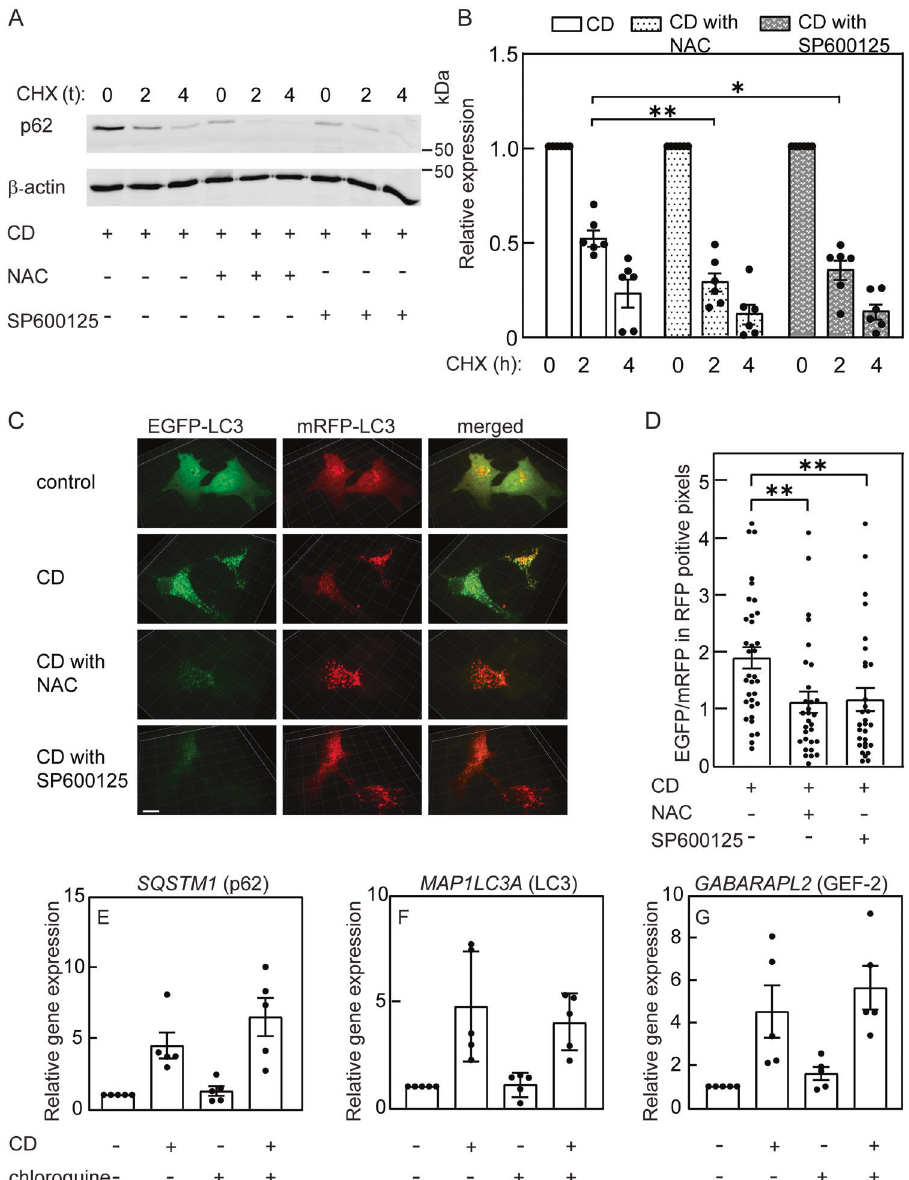
Fig. 8 Cholesterol depletion perturbs autophagic fl ux via ROS and JNK activity. A , B Mv1Lu cells were subjected to CD by statin (16 h) with or without NAC or SP600125 as in Fig. 6. They were subjected to CHX-chase degradation assay as in Fig. 4E. A A representative experiment. B Quanti fi cation of p62 degradation (mean ± SEM of 6 independent experiments). Data were normalized to β -actin, taking the zero time (prior to CHX addition) for each condition as 1. The degradation rate of p62 was signi fi cantly enhanced following NAC or SP600125 treatment (* P < 0.05; ** P < 0.01; one-way ANOVA and Dunnett ’ s multiple comparisons post hoc test). C Typical confocal 3-D renditions of LC3-EGFP-mRFP- expressing cells. Mv1Lu cells transiently transfected with the LC3-EGFP-mRFP expression vector ptfLC3 ( “ Materials and methods ” ) were subjected (or not) to CD with or without NAC or SP600125 as above, and imaged by spinning disk confocal microscopy. The EGFP signal in untreated cells was mainly diffuse, in accord with low autophagy induction. CD induced a shift to punctate labeling of EGFP and mRFP. Treatment of cholesterol-depleted cells with NAC or SP600125 reduced the EGFP signal, while the increase in mRFP LC3 puncta was retained. D Quanti fi cation of EGFP relative to mRFP levels in mRFP positive pixels, in single confocal midplanes (see “ Materials and methods ” ). The intensities measured in the respective channels of the confocal microscope were analyzed using SlideBook. Bars are mean ± SEM of measurements on 34 (CD) or 30 (CD with NAC or SP600125) cells. Under the latter conditions, the EGFP/mRFP signal was signi fi cantly reduced (** P < 0.01; Student ’ s two-tailed t -test). E – G Chloroquine treatmen t does not induce autophagy-related genes and does not perturb the increase in their expression by CD. Cells were subjected to CD (16 h) with or without chloroquine (10 μ M). The mRNA levels of autophagy- related genes were determined by RT-qPCR as in Fig. 7. No signi fi cant changes were induced by chloroquine (n.s., P > 0.05; Student ’ s two- tailed t -test). HP β CD treatment resulted in p62 accumulation (Fig. 4A – D). its cargo undergo degradation in the lysosome [23]. Indeed, Moreover, SQSTM1 transcript levels were also increased by CD induction of autophagy by rapamycin treatment signi fi cantly (Figs. 2B and 5A). Given the enhanced SQSTM1 mRNA expression, reduced p62 protein level (Fig. 4A, B), while leaving its transcript the observed increased levels of p62 protein following CD do not level ( SQSTM1 ) unchanged (Fig. 5A). In contrast, CD by statin or Cell Death Discovery (2021)